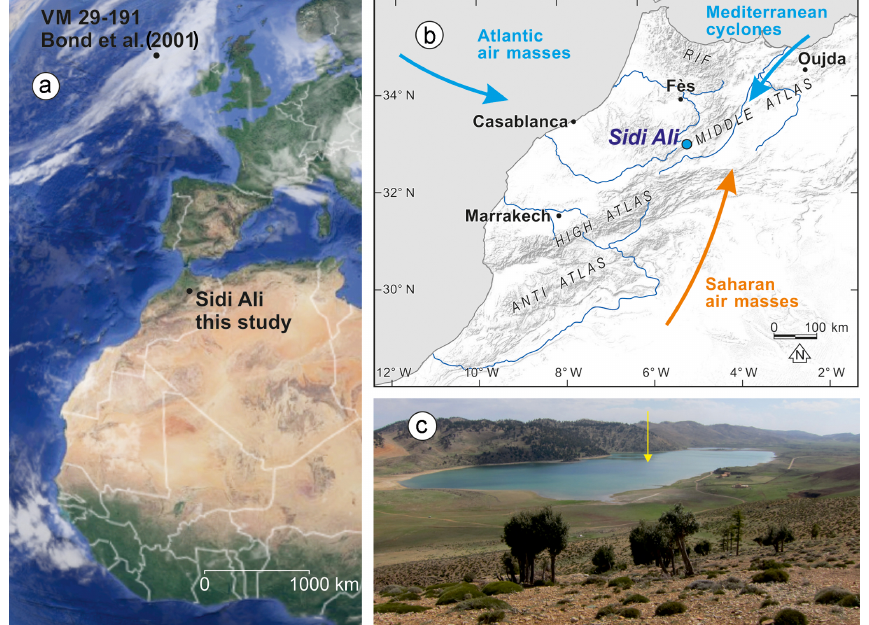
Figure 1. Geographical setting. (a) Positions of the stacked ice-rafted debris record (MC52 + VM29-191, Bond et al., 2001) and the improved Sidi Ali oxygen stable isotope record (this study). (b) Regional context of Lake Sidi Ali in the Moroccan Middle Atlas; arrows indicate impacts of different air masses on Holocene climate history. (c) Lake Sidi Ali; the yellow arrow shows the core